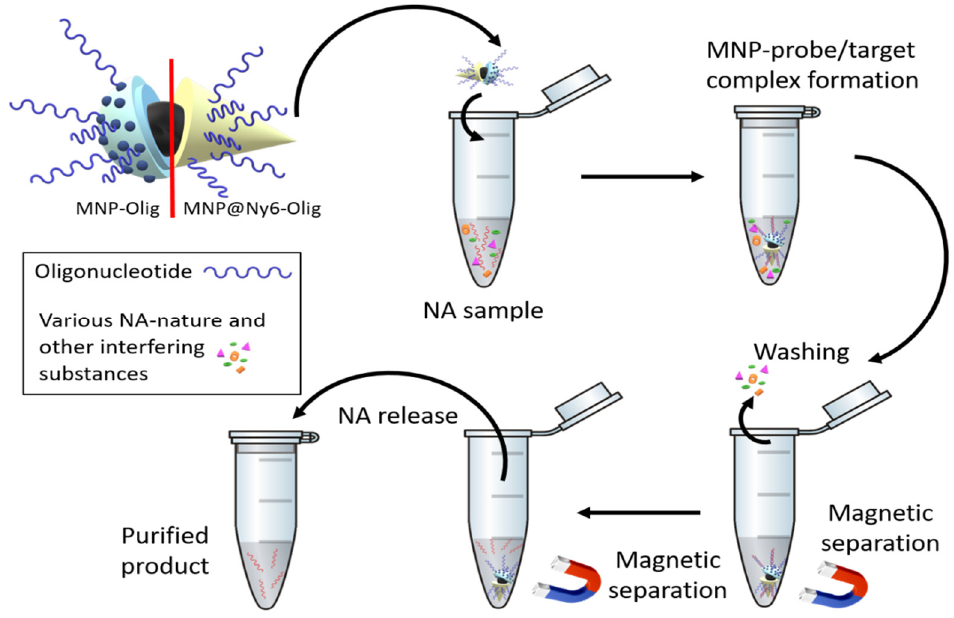
Figure 5. Basic principles of NA magnetic solid-phase extraction.